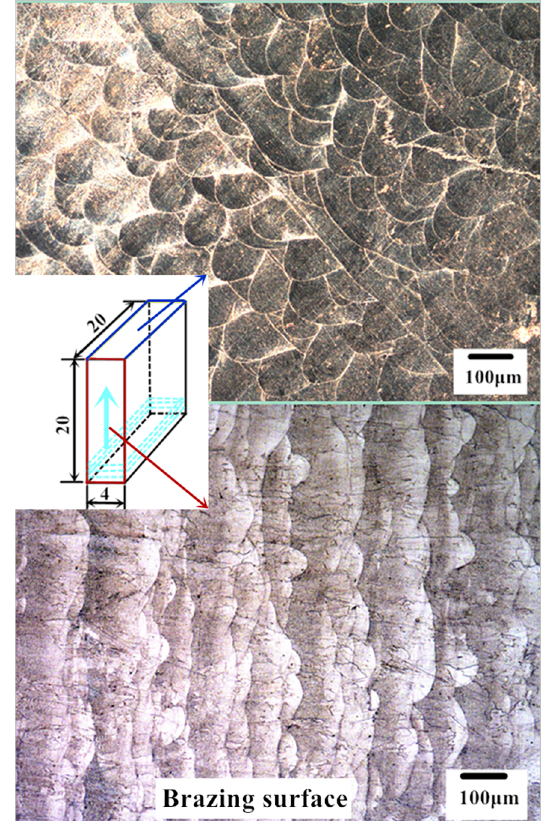
Figure 1. Fabricating schematic of the base material. Figure 2. Microstructure of the base